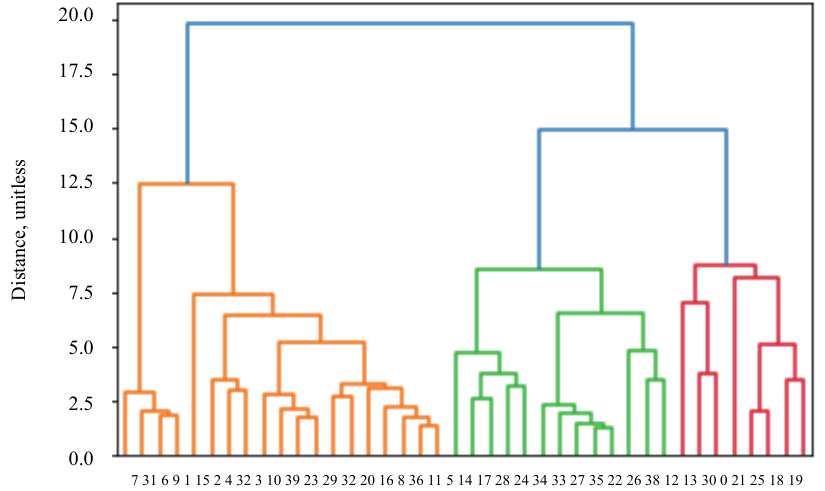
Fig. 1. Dendrogram of Hierarchical